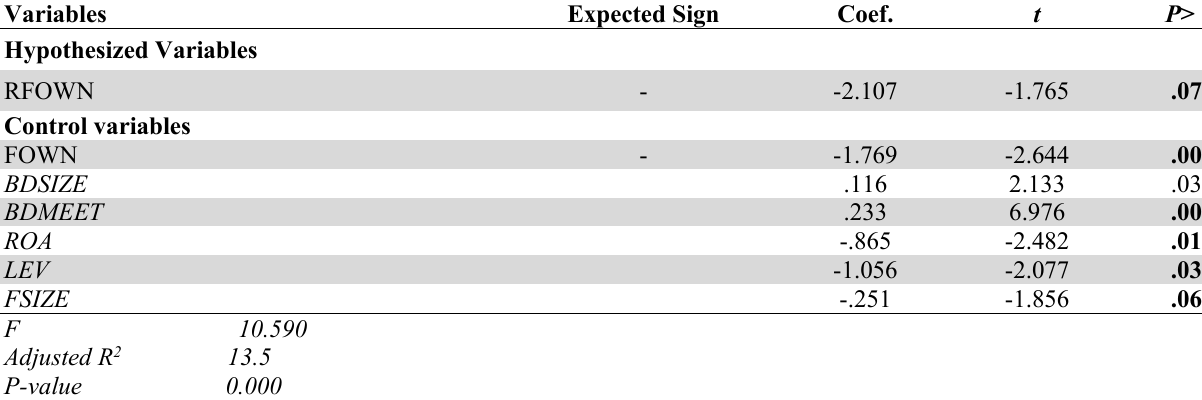
Audit committee effectiveness regression model